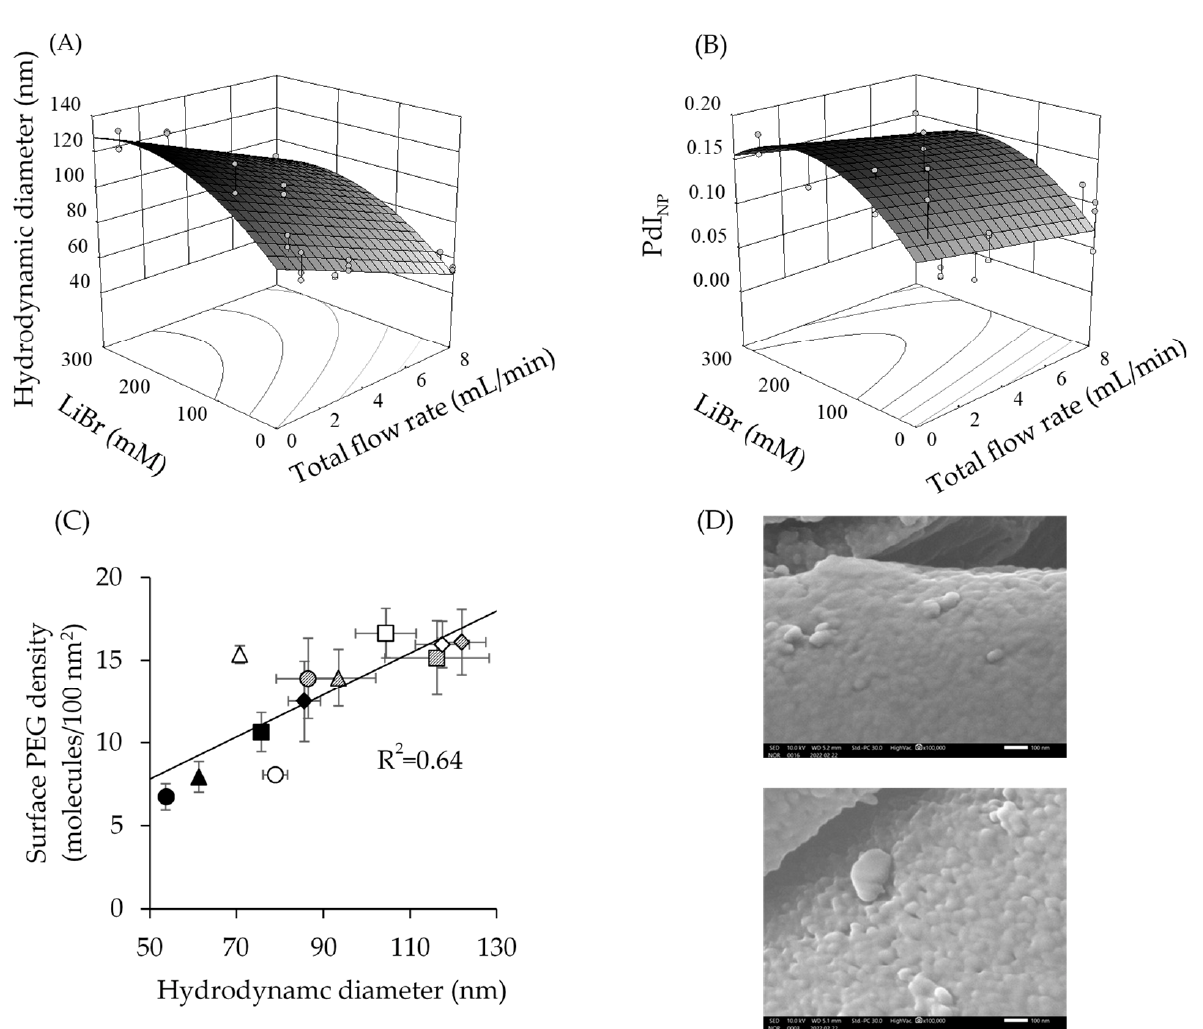
Figure 6. Response surface of hydrodynamic diameters (D h ) and polydispersity (PdI NP ) of nanoparticles (NPs), relationship between D h and surface PEG densities, and FE-SEM image of lyophilized NPs. Panels ( A , B ) show the response surface of D h and PdI NP , respectively. Circle symbols indicate individual values. Response surfaces were fitted by quadratic models. Panel ( C ) indicates surface PEG densities plotted as a function of D h . Closed, open, and hatched symbols indicate TFRs of 8 mL/min, 3 mL/min, and 1 mL/min, respectively. Circles, triangles, squares, and diamonds indicate LiBr concentrations = 0 mM, 20 mM, 100 mM, and 300 mM, respectively. Results are expressed as the mean ± standard deviation of three samples. Correlation curves were fitted by a linear model using the least squares method. Panel ( D ) shows the FE-SEM image magnified 100,000 times. The upper panels show morphologies of lyophilized NPs prepared with 20 mM LiBr/TFR 8 mL/min. The lower panel shows the morphology of lyophilized NPs prepared with 100 mM LiBr/TFR 3 mL/min. Bars represent 100 nm scales. Tissue distributions of 111 In-SC-PEG NPs (Figure 7B,C) and 14 C-TAM (Figure 7E,F)